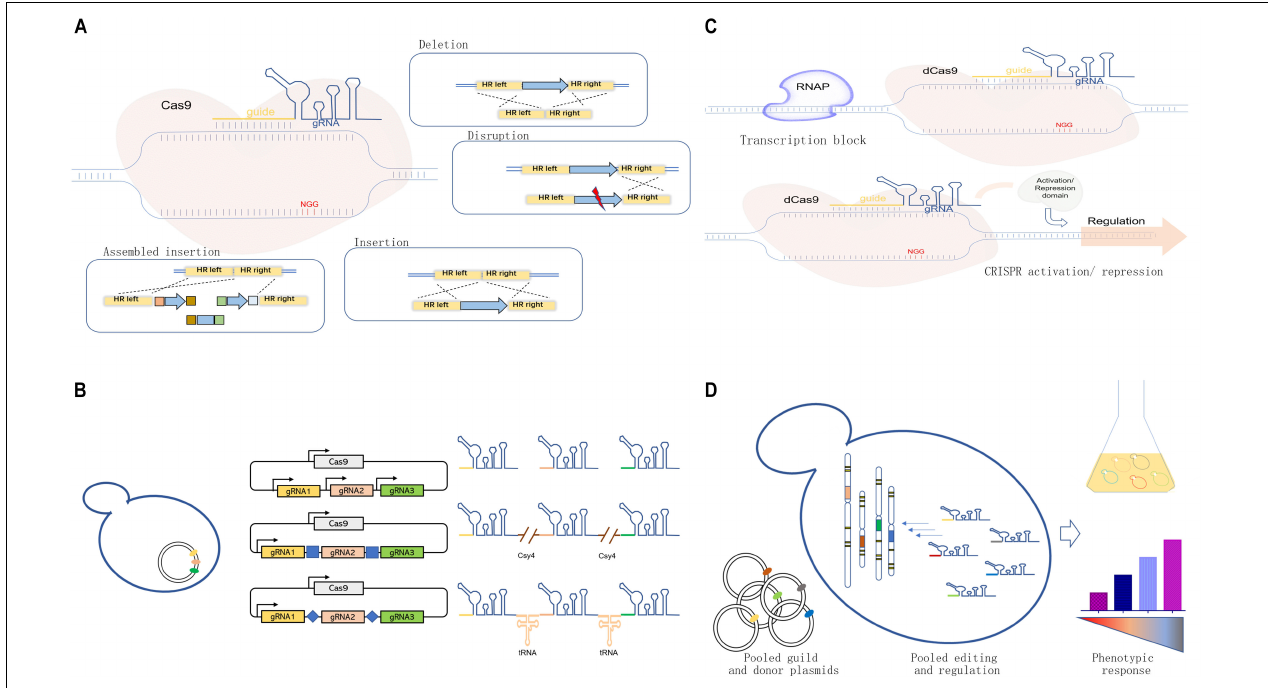
FIGURE 1 | Development and applications of the clustered, regularly interspaced, short, palindromic repeat-associated (CRISPR)/CRISPR-associated protein 9 (Cas9) systems in yeast cell factory engineering. (A) Scheme of the CRISPR/Cas9 system for genome editing, including gene deletion, mutation or disruption, insertion, and assembled insertion. (B) Guide RNA (gRNA) multiplexing strategies, including multi-single guide RNA (multi-sgRNA) expression through the use of multiple promoters or the expression of one-promoter-guided single transcript separated by different features for RNA cleavage. (C) dCas-meditated CRISPRi and CRISPRa systems for transcriptional regulation achieved through physically blocking RNA polymerase (RNAP) or recruiting protein effectors for target repression/activation. (D) Pooled gRNA-guided genome-scale engineering or